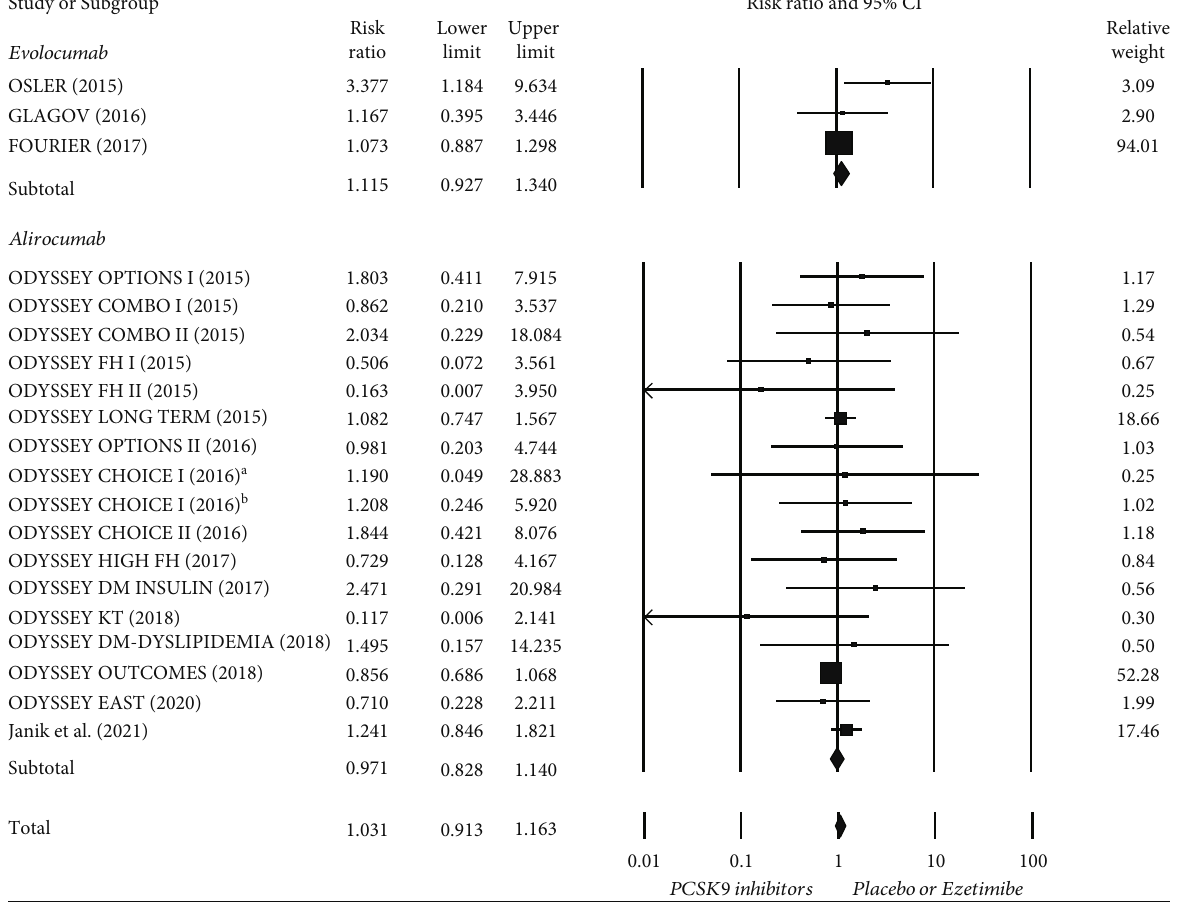
Figure 4: Forest plot of neurocognitive and neurologic adverse events compared between PCSK9 inhibitors and control treatment (placebo or ezetimibe). a Treatment with alirocumab Q2W; b Treatment with alirocumab